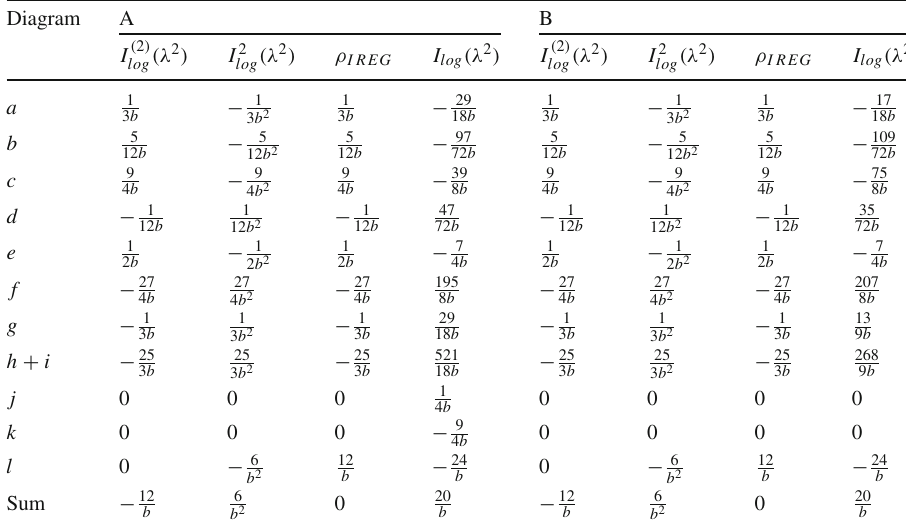
Fig. 3 Two-loop correction to the two-point function of the background field A Table 10 Results for